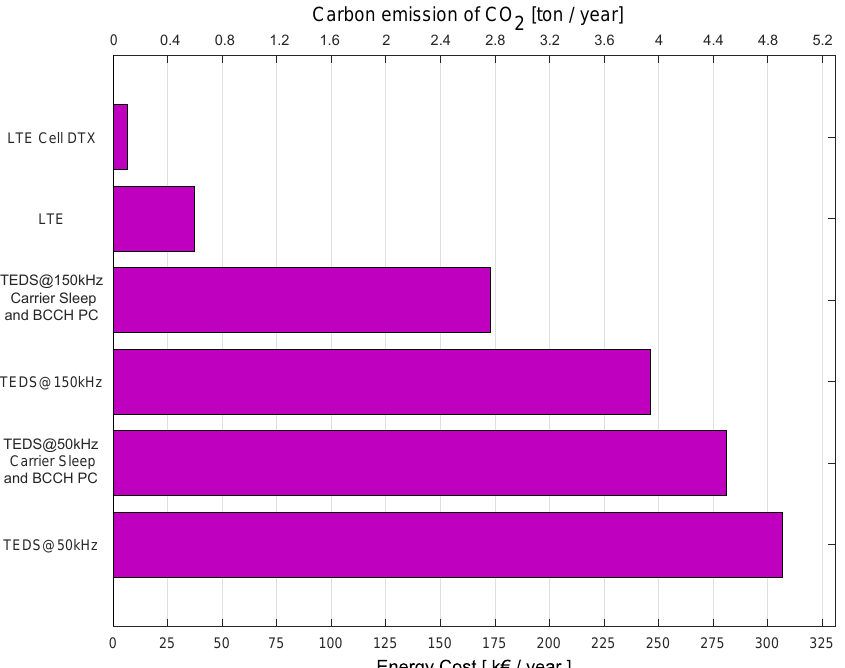
Figure 12. Annual energy expenditure and carbon emission of CO 2 for TETRA and LTE